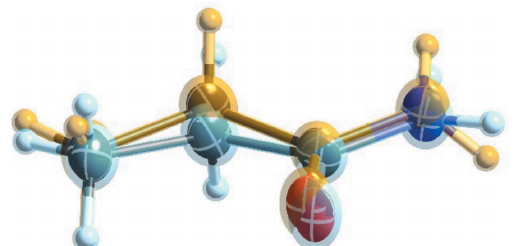
Figure 7 Displacement ellipsoid representations of the molecular structure of propionamide, CSD refcode ZZZKAY03, from restrained/constrained refinement. The illustration was generated with SHELXLE (Hu¨bschle et al. ,